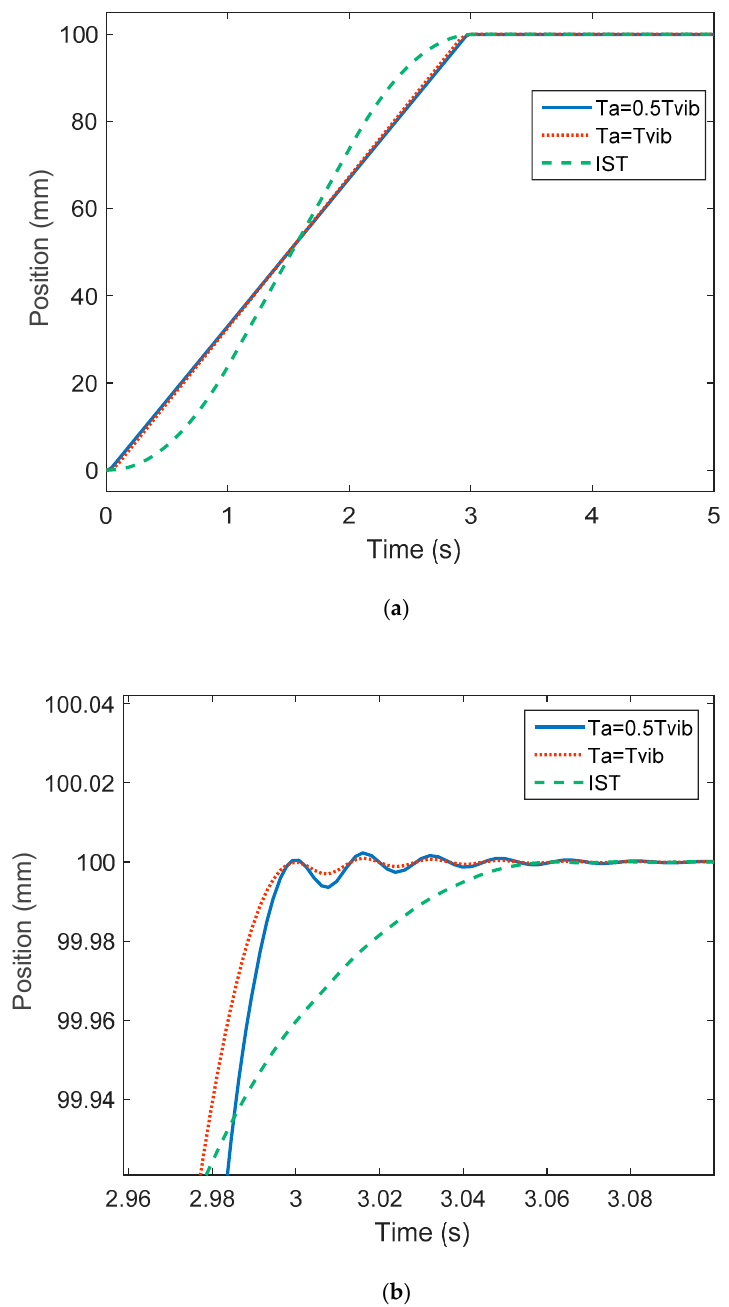
Figure 23. Comparison of residual vibration when the proposed method is applied and the IST is applied: ( a ) trajectory; ( b ) residual vibrations.